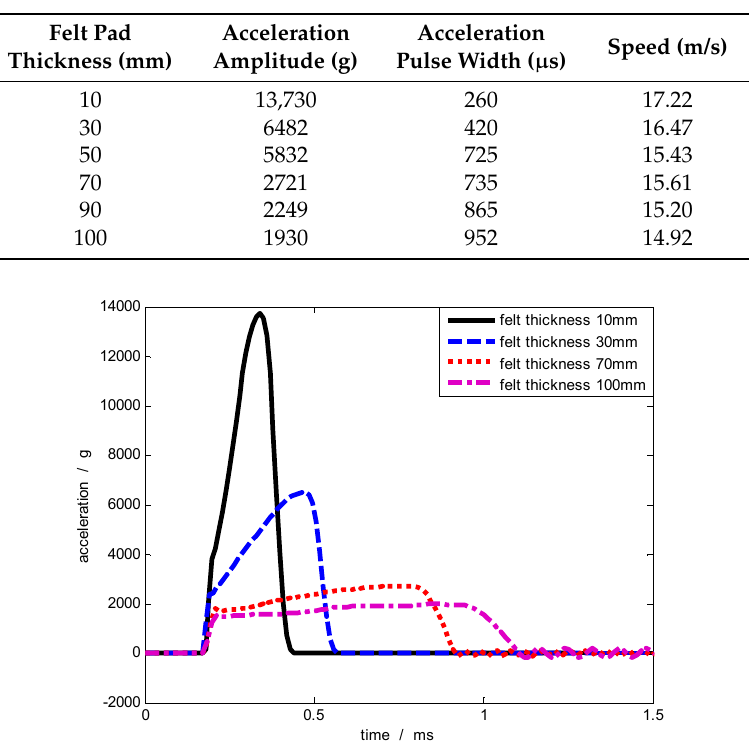
Table 4. Influences of felt pad thickness on excitation pulse width.